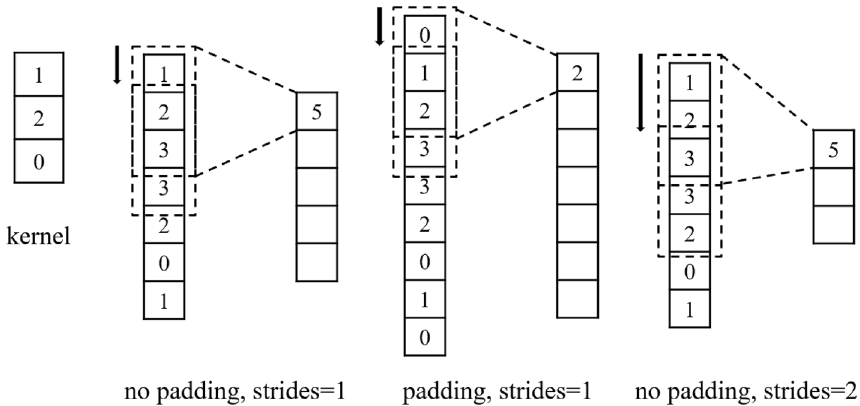
Figure 1. This is a schematic diagram of one-dimensional convolution.